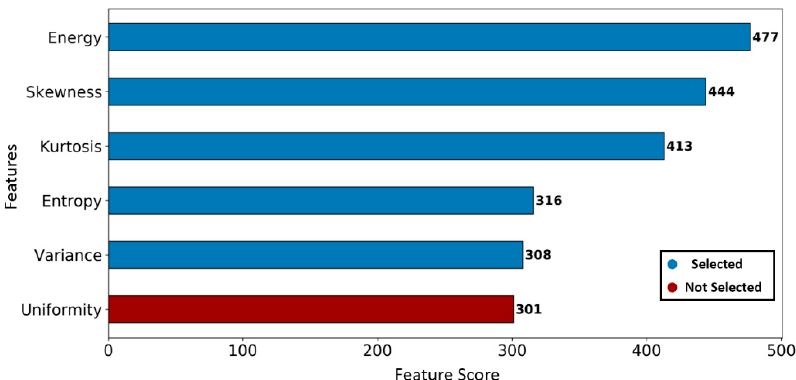
Figure 6. Feature ranking using the recursive feature elimination technique. The best five significant features are selected with the largest ranking values.